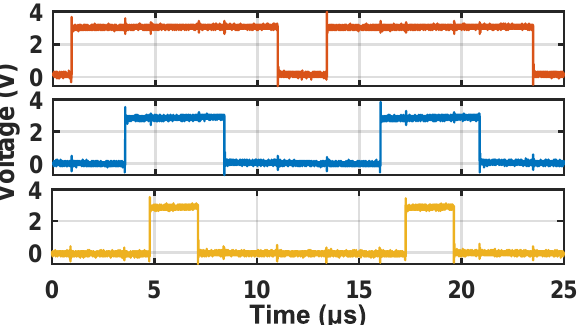
Figure 15. The PWM signal of the SVPWM algorithm with OVDT of 1-norm.